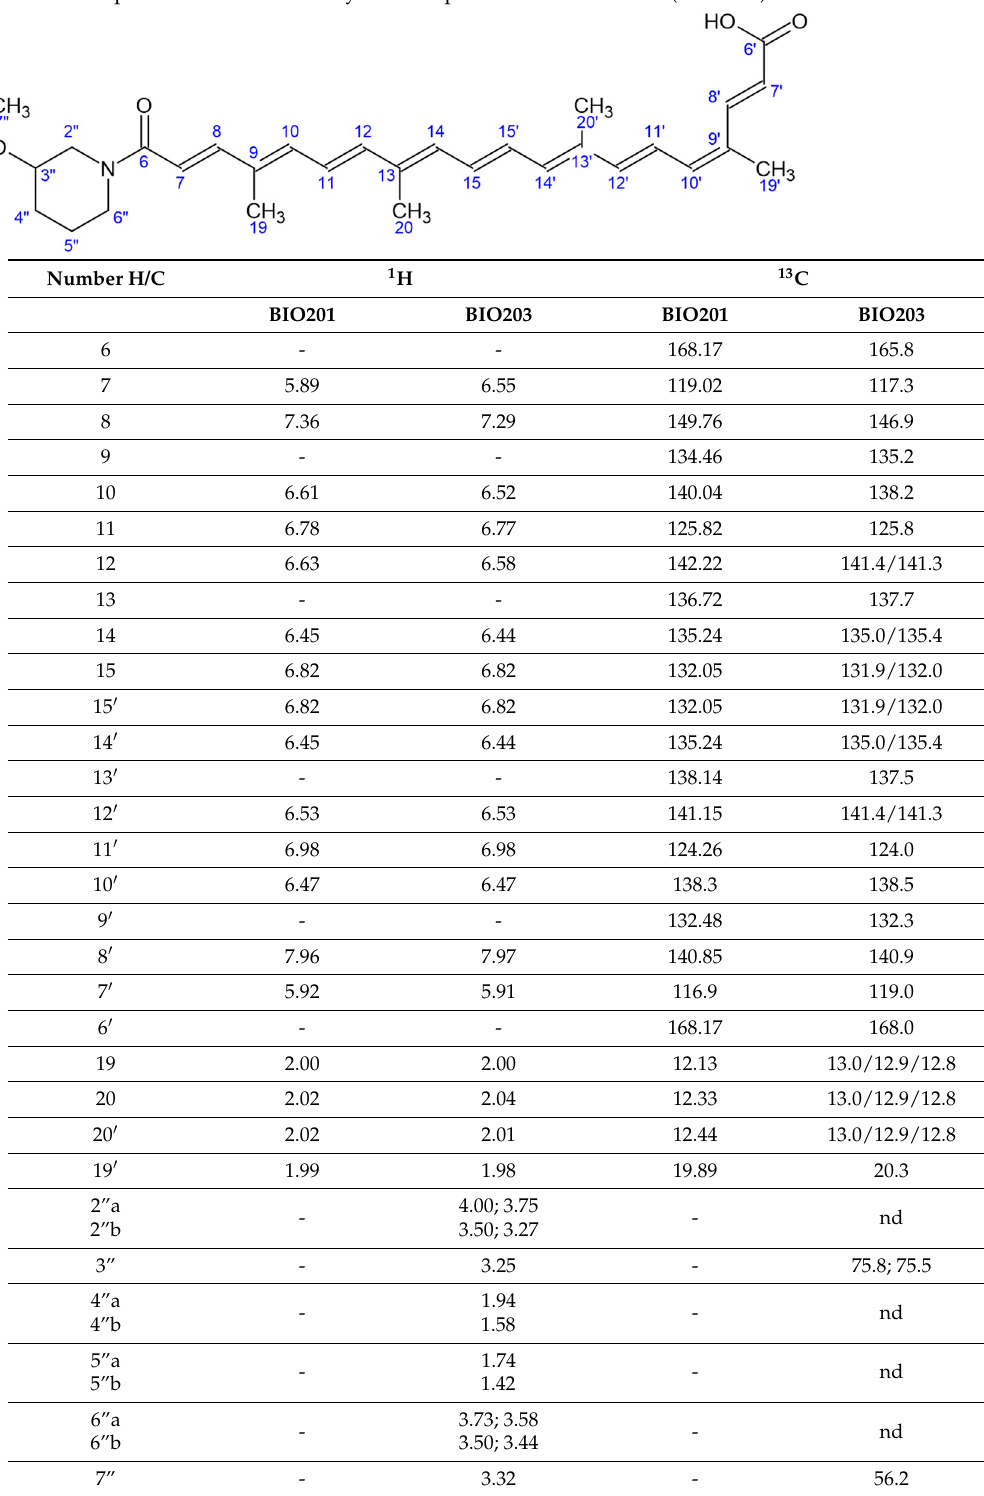
Table 1. Comparative identification by NMR of protons and carbons in (norbixin) BIO201 and BIO203.